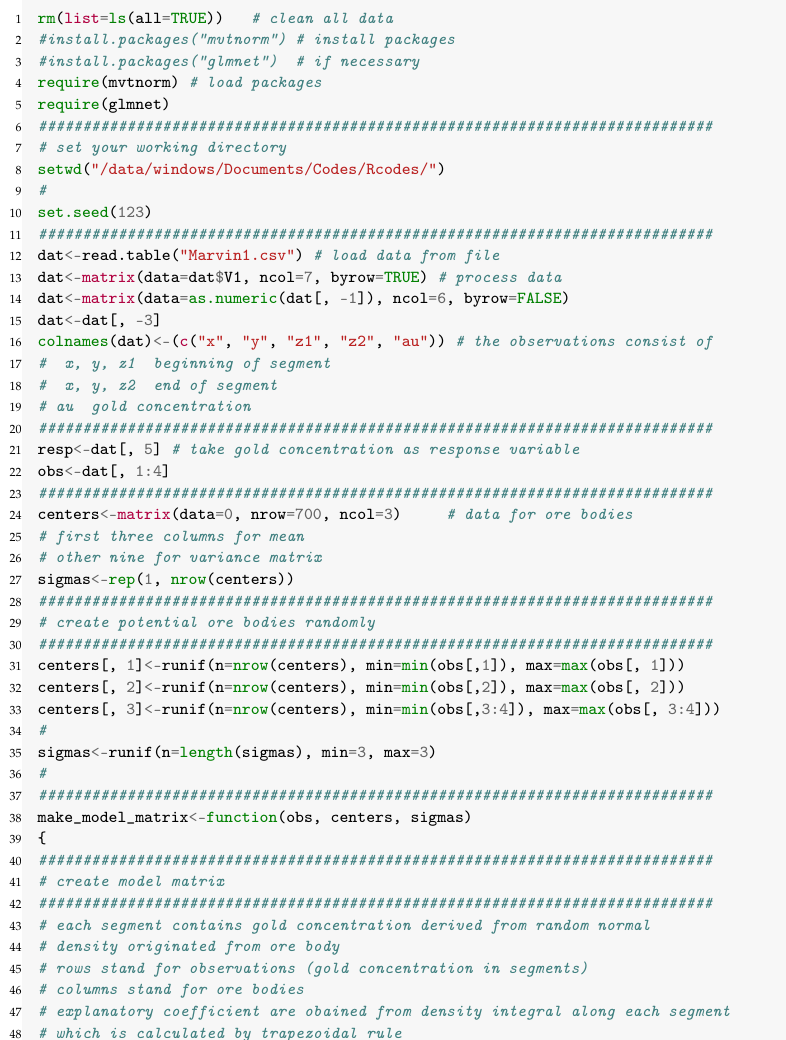
Figure A4. Distribution of ore from RL447.5 to RL445, sampling interval 7.5–10m, consistent increase of grades with the